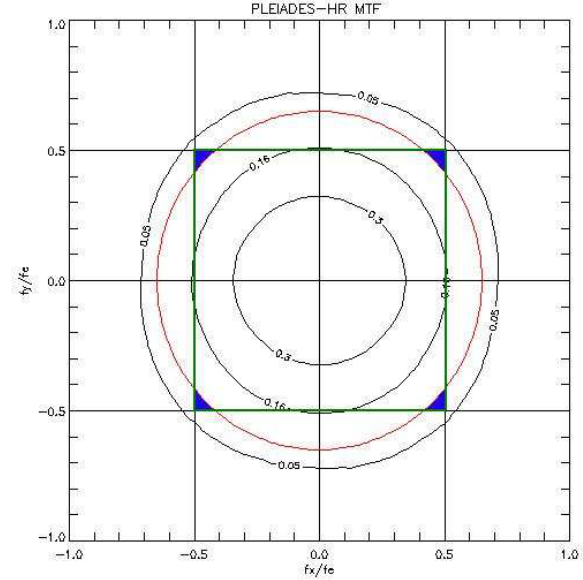
Figure 14. Level lines of the PA Pleiades MTF (in black). Axis fx (resp. fy) represents the frequency along X and Y directions. Reciprocal cell (in green). At Nyquist frequency (abs(fx/fe)=abs(fy/fe)=0.5), the MTF is equal to